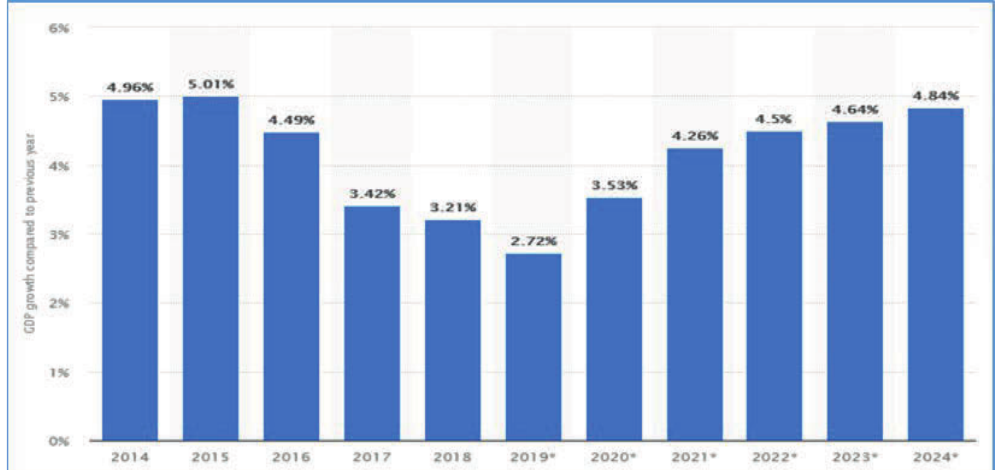
Fig. 3. Forecast of GDP of Sri Lanka compared to previous year, % (Department of Census & Statistics, Sri Lanka,